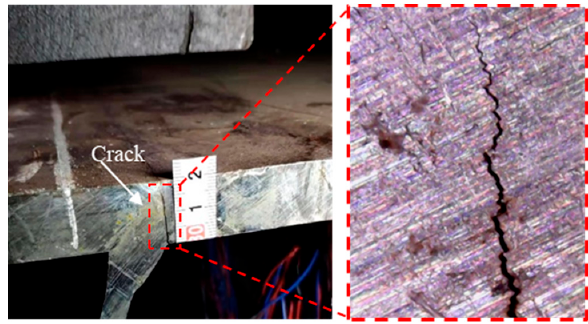
Figure 5. Typical fatigue cracking pattern of tested specimens.